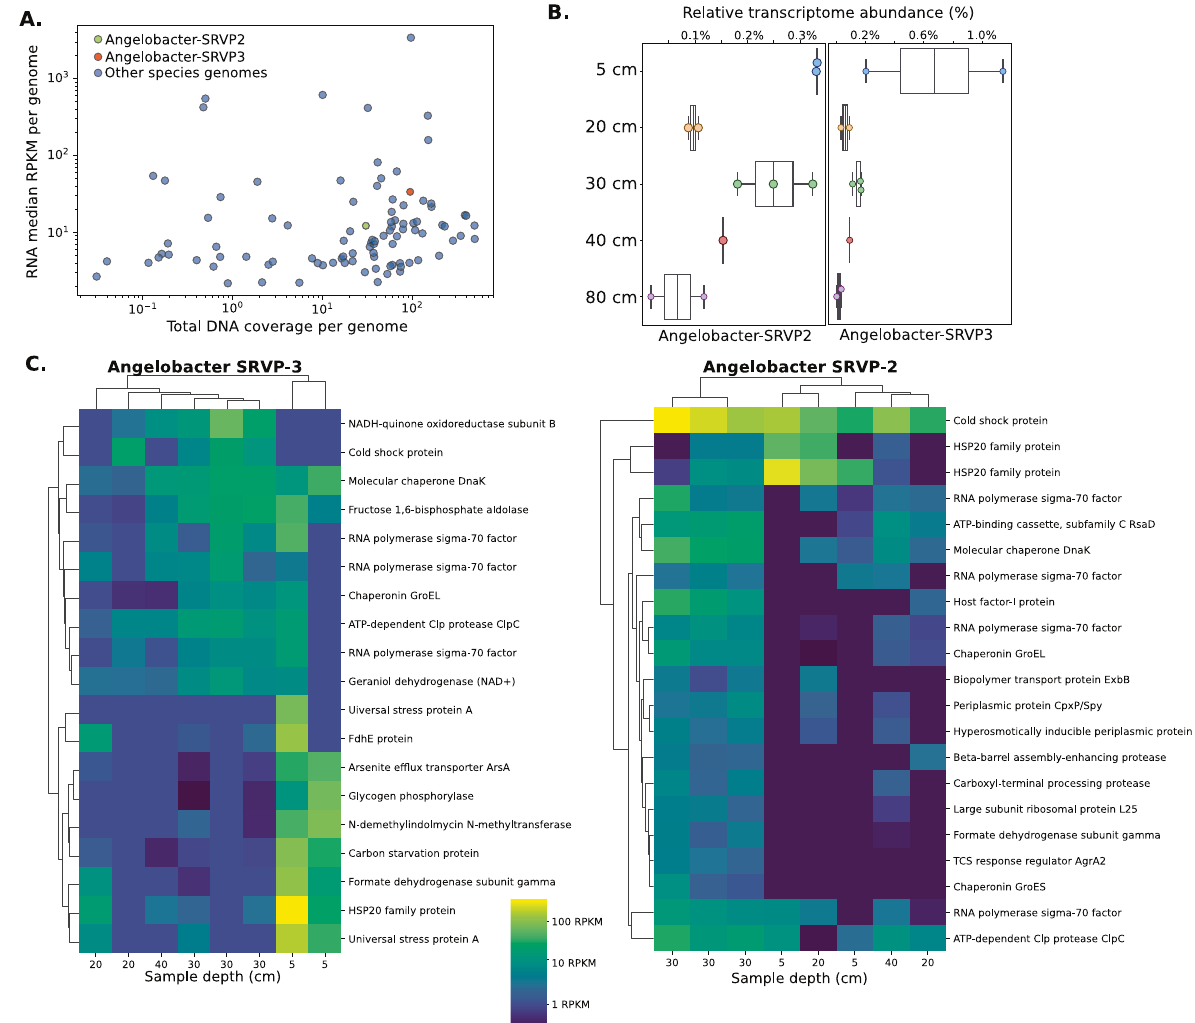
Fig. 4 Metatranscriptomic activity of Candidatus Angelobacter species in situ. A RPKM-normalized metatranscriptomic ( y -axis) and coverage-normalized metagenomic ( x -axis) reads mapping to two Ca . Angelobacter species, compared to all other microbes with genomes obtained from the vernal pool site, in samples from soil depths of 5 – 20 cm. B Genome-wide transcriptional activity for two Ca . Angelobacter species, compared by sediment depth of sampling. C Transcriptomic RPKM of the 50 most highly expressed genes with assigned Kegg Orthologs (KOs) at each sampling depth for the two Ca . Angelobacter